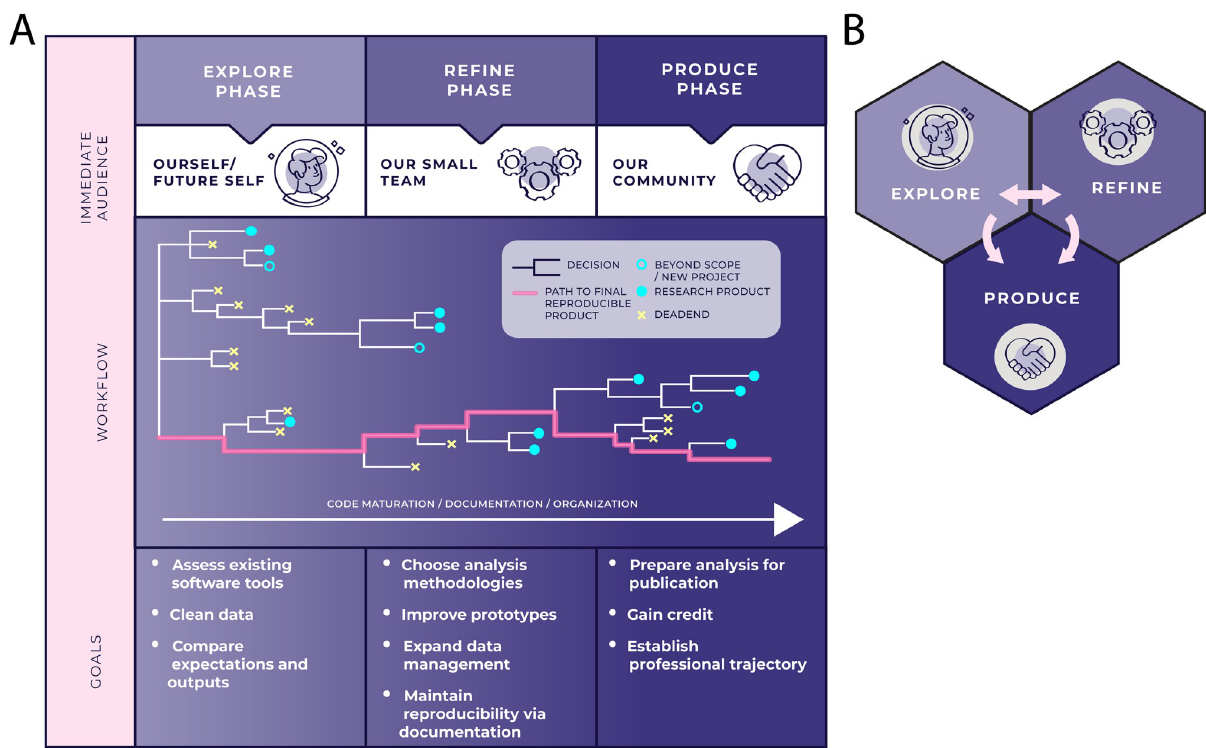
Fig 1. ERP workflow for data-intensive research. (A) We deconstruct a data-intensive research project into 3 phases, visualizing this process as a tree structure. Each branch in the tree represents a decision that needs to be made about the project, such as data cleaning, refining the scope of the research, or using a particular tool or model. Throughout the natural life of a project, there are many dead ends (yellow Xs). These may include choices that do not work, such as experimentation with a tool that is ultimately not compatible with our data. Dead ends can result in informal learning or procedural fine-tuning. Some dead ends that lie beyond the scope of our current project may turn into a new project later on (open turquoise circles). Throughout the Explore and Refine Phases, we are concurrently in the Produce Phase because research products (closed turquoise circles) can arise at any point throughout the workflow. Products, regardless of the phase that generates their content, contribute to scientific understanding and advance the researcher’s career goals. Thus, the data-intensive research portfolio and corresponding academic CV can be grown at any point in the workflow. (B) The ERP workflow as a nonlinear cycle. Although the tree diagram displayed in Fig 1A accurately depicts the many choices and dead ends that a research project contains, it does not as easily reflect the nonlinearity of the process; Fig 1B’s representation aims to fill this gap. We often iterate between the Explore and Refine Phases while concurrently contributing content to the Produce Phase. The time spent in each phase can vary significantly across different types of projects. For example, hypothesis generation in the Explore Phase might be the biggest hurdle in one project, while effectively communicating a result to a broader audience in the Produce Phase might be the most challenging aspect of another